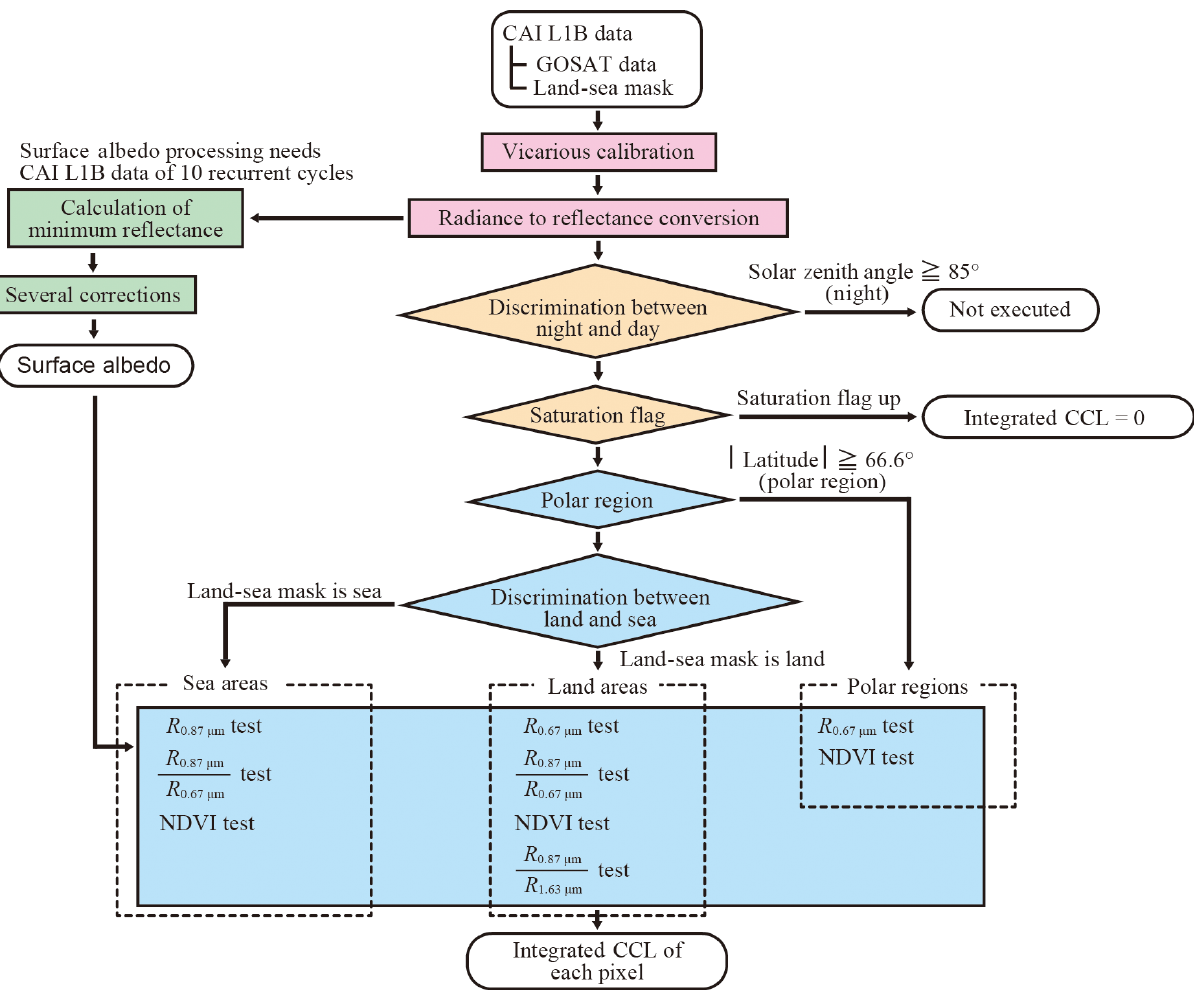
Figure 6. Flow chart for CLAUDIA1–CAI. For sun-glint areas, the thresholds are further increased based on the R 0 . 87µm test. CCL is confidence level, R wavelength is reflectance, NDVI is normalized difference vegetation